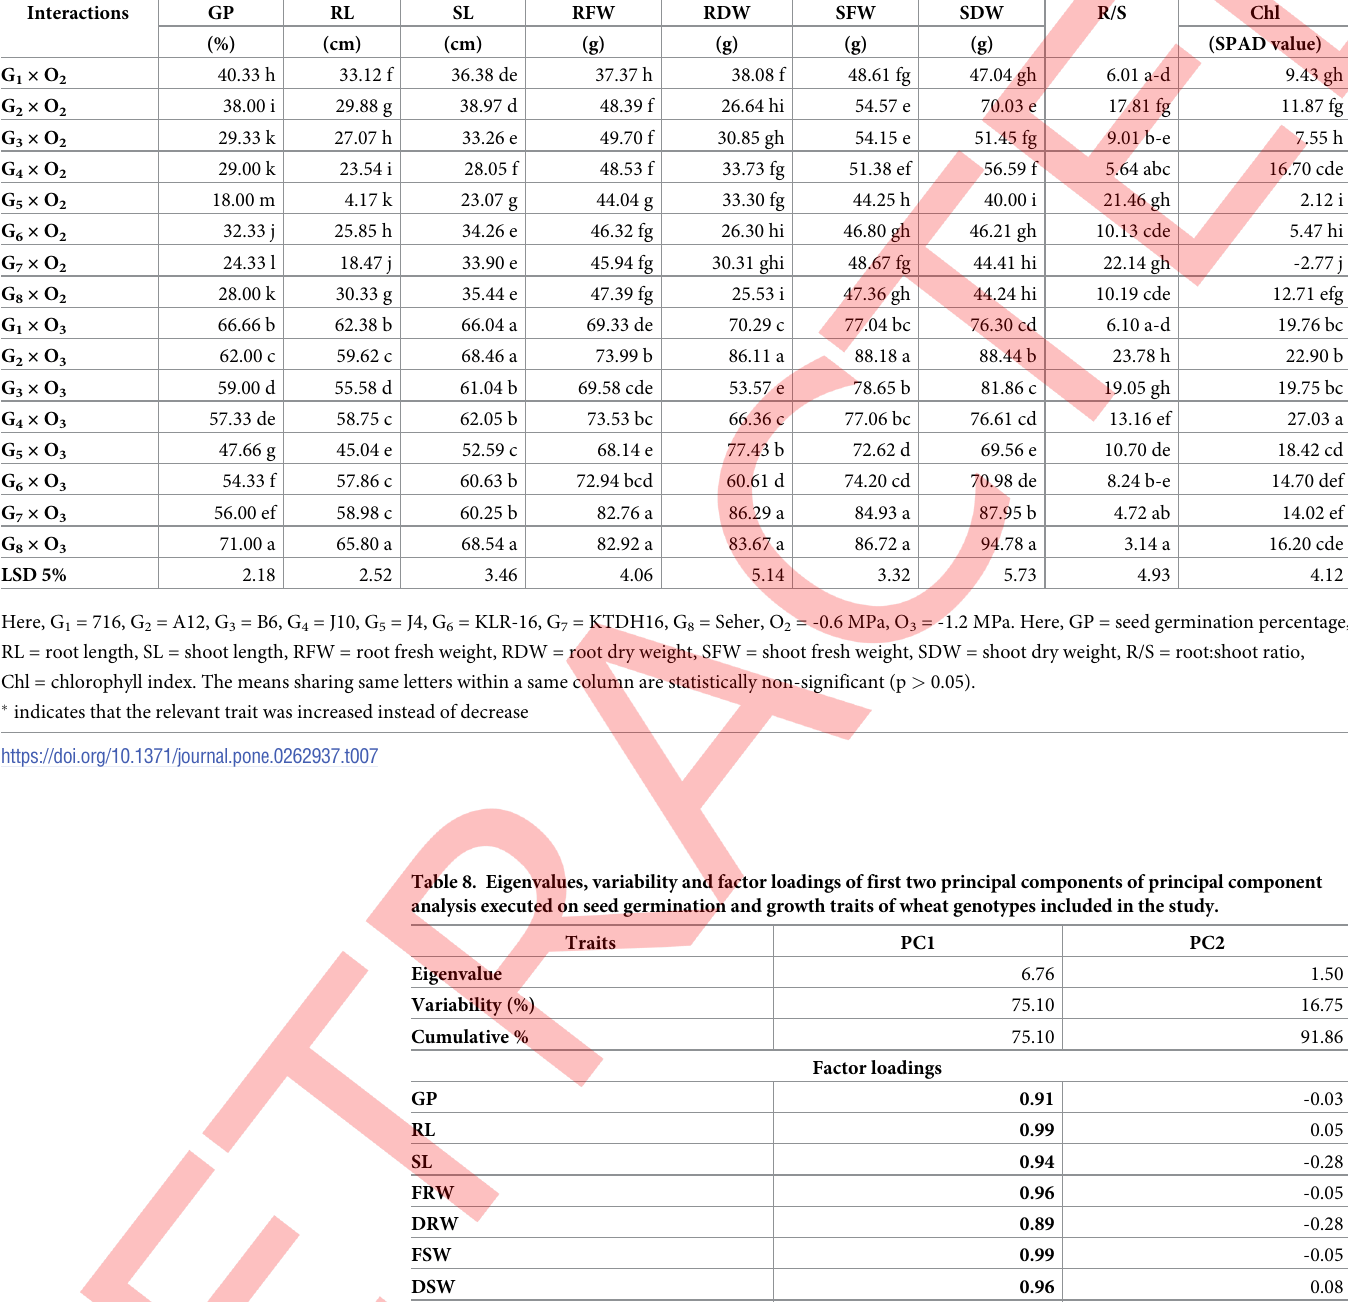
Table 7. The impact of wheat genotypes by different osmotic potentials’ interaction on decrease in seed germination and growth traits of wheat genotypes included in the study. Interactions